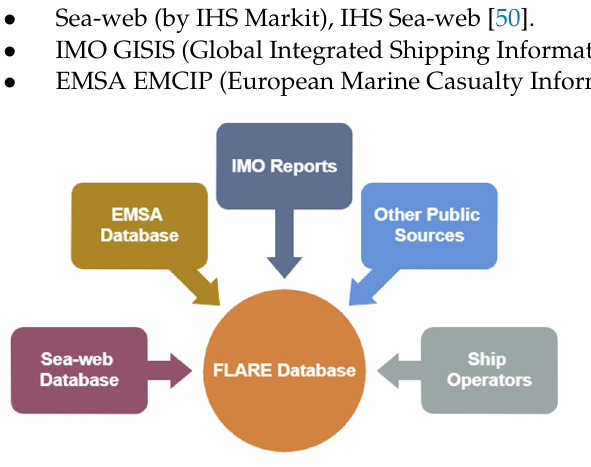
Figure 14. Main information sources of the FLARE Figure 14 . Main information sources of the FLARE database .